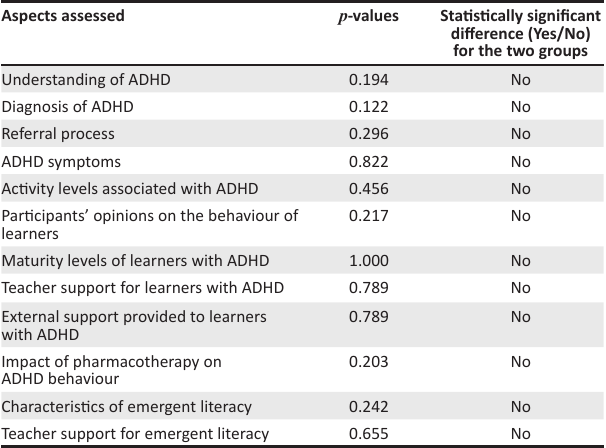
TABLE 5: Overall findings for both groups: Statistically significant differences in knowledge for each of the areas assessed. Aspects